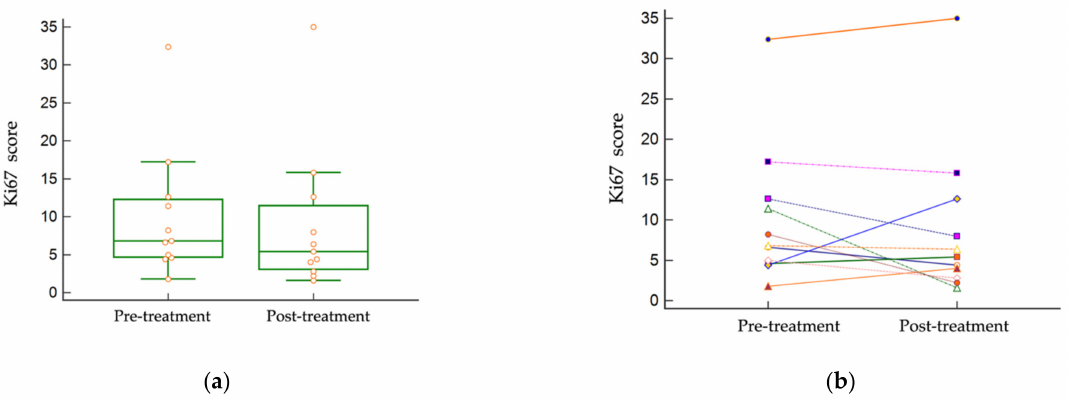
Figure 3. Ki67 scores in paired tumor samples. There was no statistically significant difference between pre- and post-treatment Ki67 scores ( p = 0.4393). ( a ) Distribution of Ki67 scores pre- and post-treatment. ( b ) Individual tumor paired Ki67